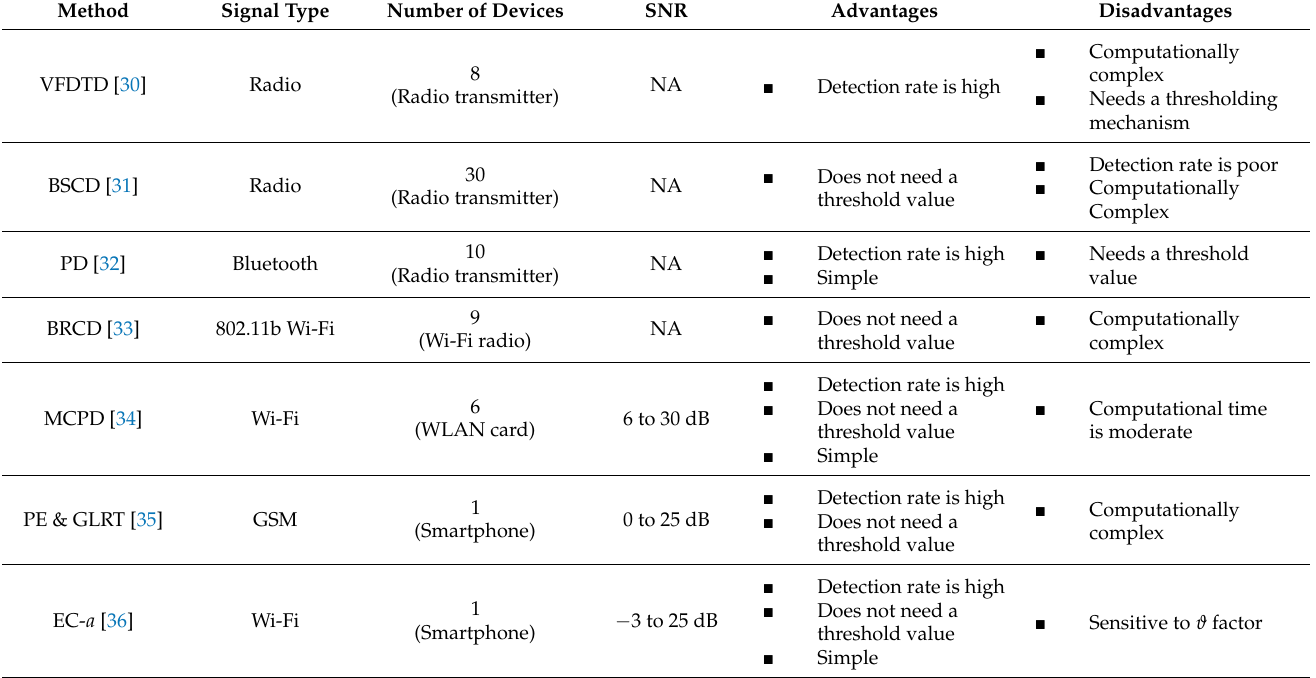
Table 1. A summary of existing transient detection